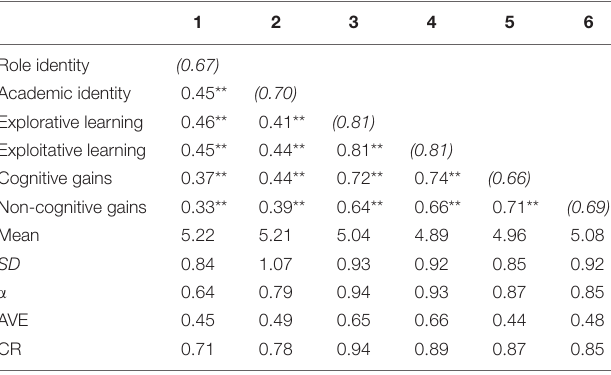
TABLE 2 | Reliability and validity of the variables used in this